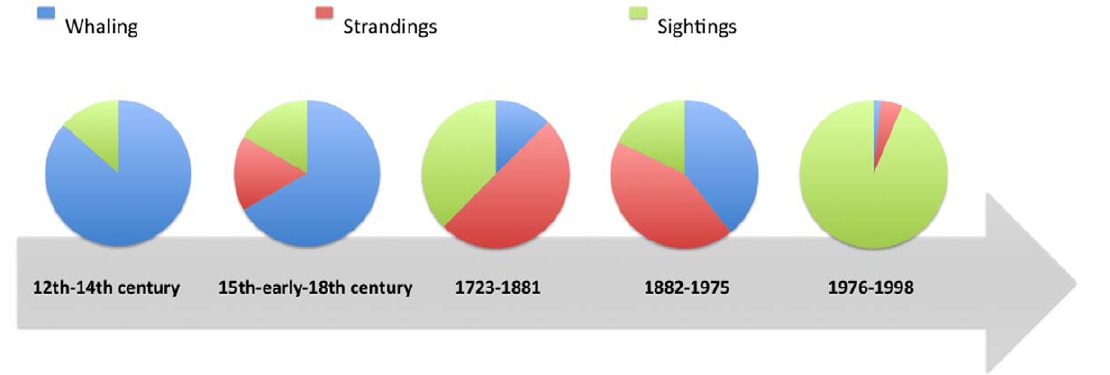
Figure 6. Number of historical and recent accounts for cetaceans over time (n=142), including both historical sources and scientific publications, considering the three main activities related to cetacean presence (whaling, strandings and sightings).